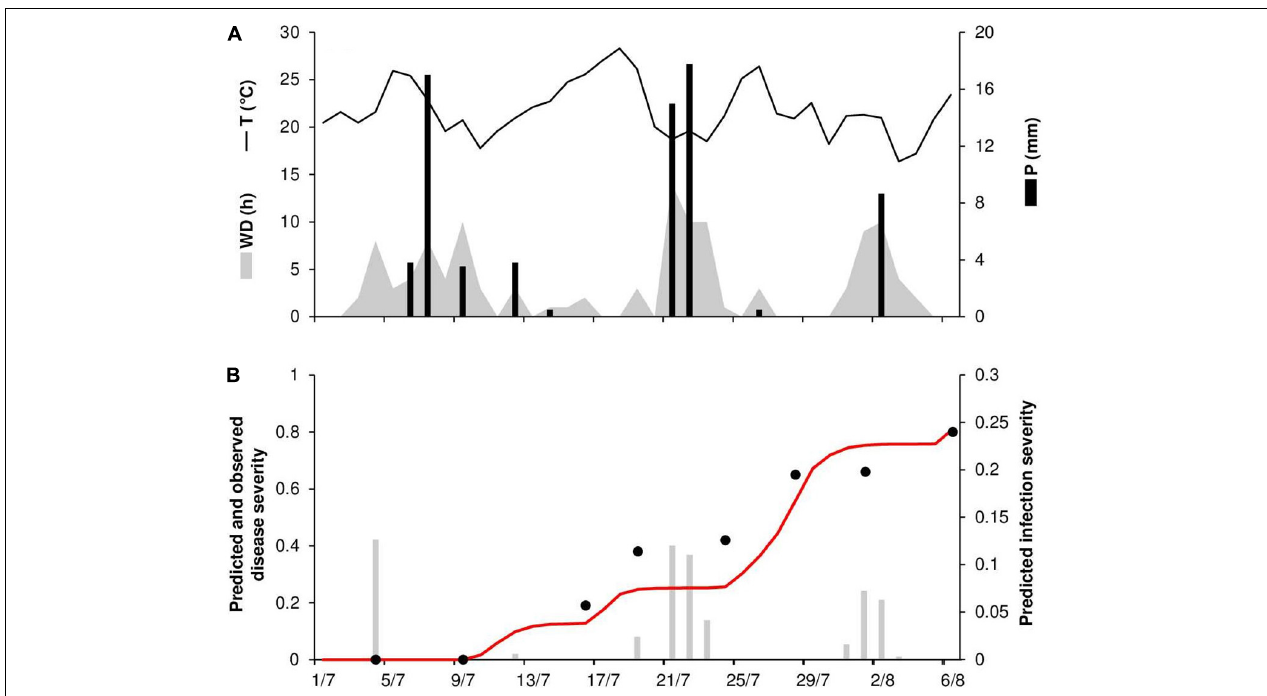
FIGURE 8 | Predicted and observed stem rust progress in the experimental wheat field (susceptible cv. Prelude) in St. Paul, MN, United States, in 1978 (STP78). (A) Weather variables: air temperature (T, ◦ C, solid line), rainfall (R, mm, black bars), and wetness duration (WD, in h, gray area). (B) Infection severity predicted by the model (gray bars), disease severity predicted by the model (red line), and observed disease severity (full dots).